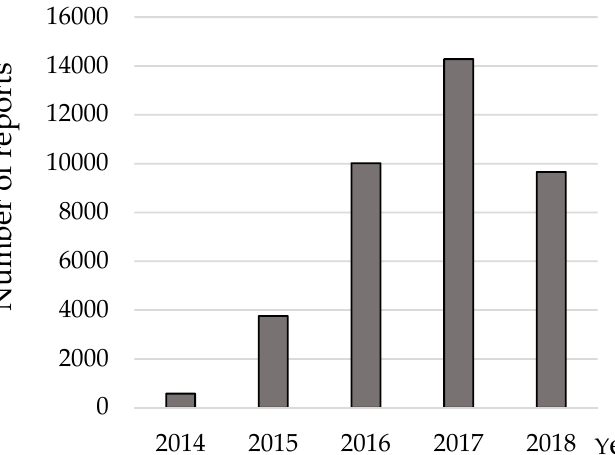
Figure 1. Adopted from Reference [49]. Food and Drug Administration (FDA)-reported numbers of immune-related Adverse Events (irAEs) with anti programmed cell death 1 (PD-1) / programmed death ligand 1 (PD-L1) antibody monotherapy versus anti PD-1 / PD-L1 antibody plus anti cytotoxic T-lymphocyte antigen-4 (CTLA-4) antibody combination treatment. (Number of reports up to June in